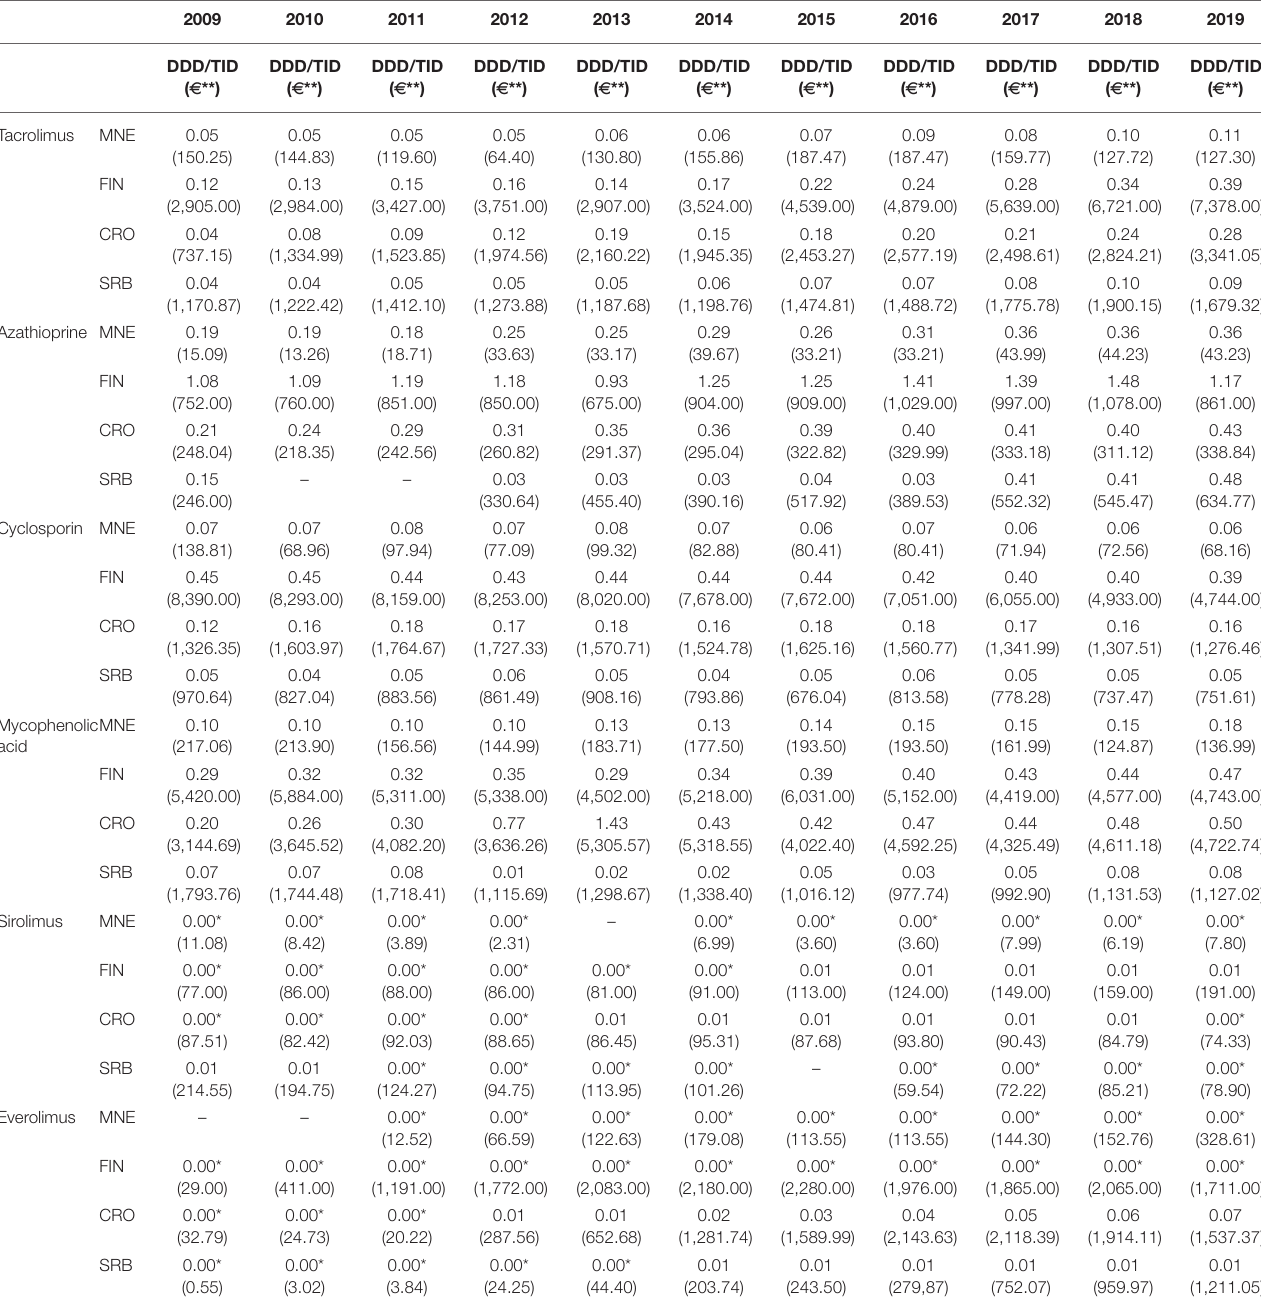
TABLE 1 | Overview of the consumption of tacrolimus, azathioprine, cyclosporin, mycophenolic acid, sirolimus, and everolimus in Montenegro, Finland, Croatia, and Serbia in the period 2009–2019, presented as the number DDD/TID and euros ( e